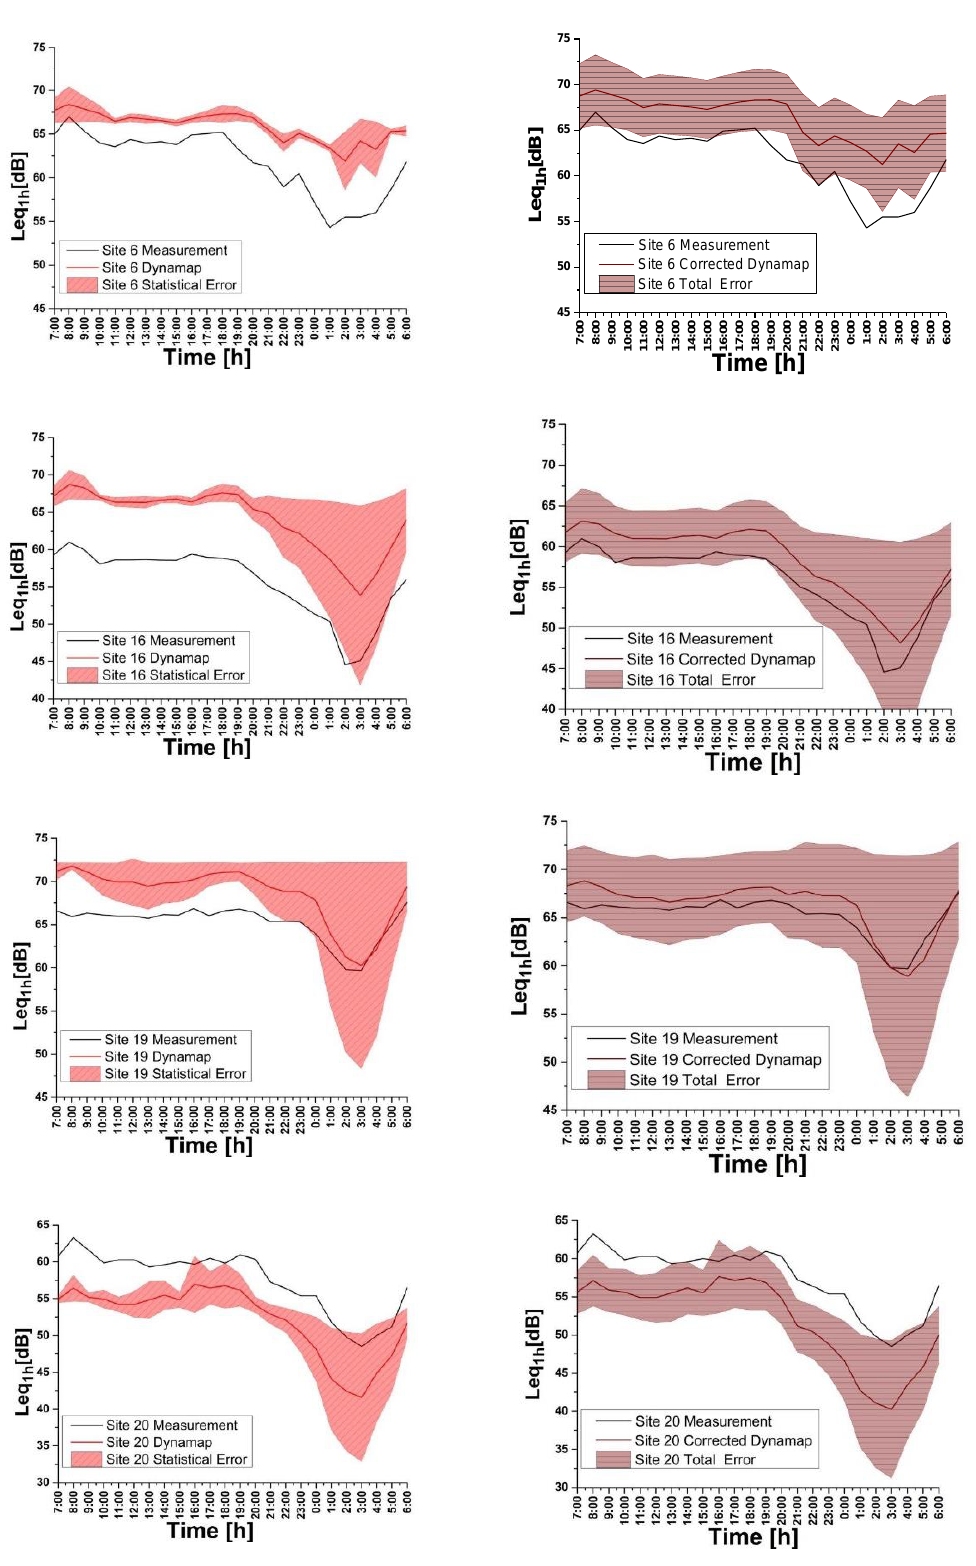
Figure 16. (Left part) Comparison of tra ffi c noise measurements and DYNAMAP (non-corrected) prediction for: Site 16 (Upper panel), Site 19 (Middle panel), Site 20 (Lower panel). (Right part) Comparison of tra ffi c noise measurements and DYNAMAP (corrected) prediction for the same sites. In the figure, the total error is